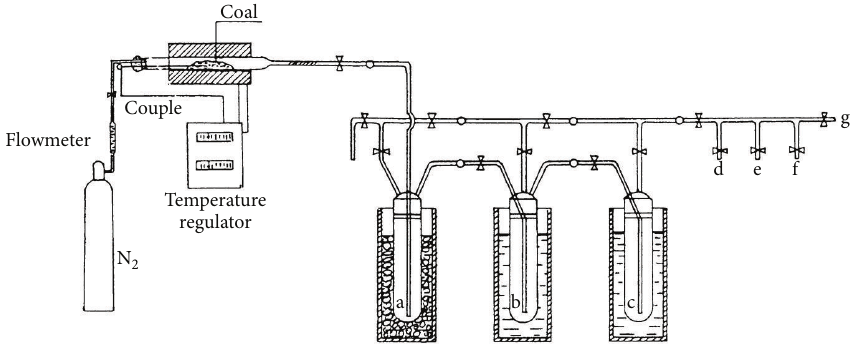
Figure 1: System used for heating coals up to 800 ∘ C: (a) cooling trap with water + salts at − 15 ∘ C; (b) cooling trap with solid CO 2 (s) + acetone at − 77 ∘ C; (c) cooling trap with liquid nitrogen at − 180 ∘ C; (d), (e), (f), and (g) taps. vacuum and the working temperature was set. The same procedure was repeated for all temperatures (from 100 ∘ C to 800 ∘ C), performing the same thermal gradient for all experi-